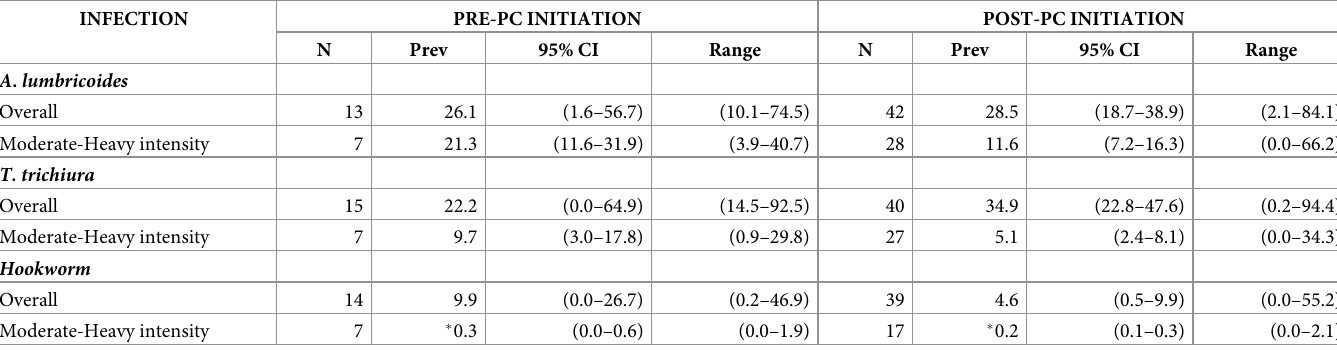
Table 4. Meta-analyses of prevalence of A . lumbricoides , T . trichiura , and hookworm by preventive chemotherapy status and population group, pre-PC initiation restricted to 5 years before PC and post-PC initiation restricted to 5 years post-PC.